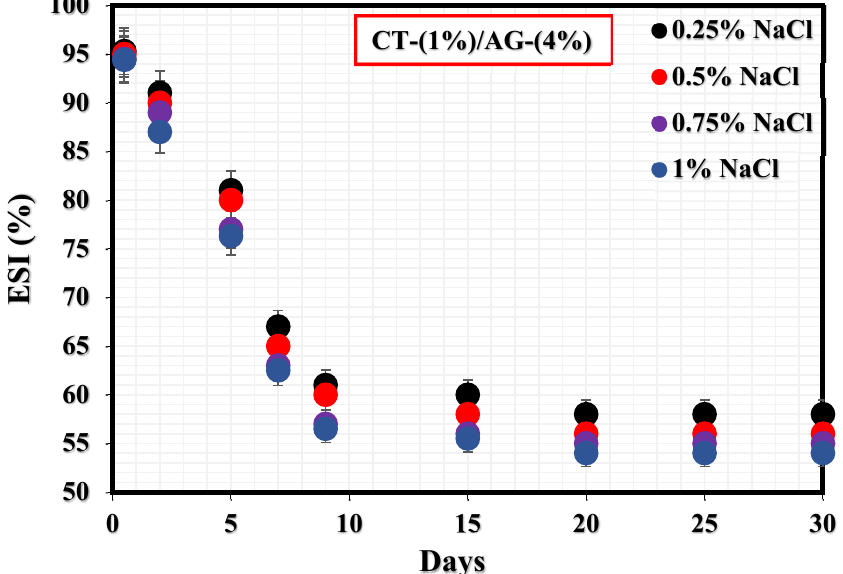
Figure 3. Stability tests of CT/AG Pickering emulsions at varying NaCl concentrations.